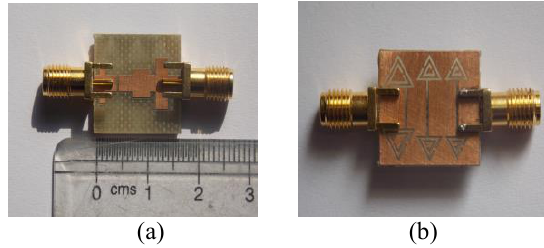
Fig. 10: Fabricated layout of proposed microstrip bandpass filter with triangular CSRR-DGS: (a) top view (b) bottom